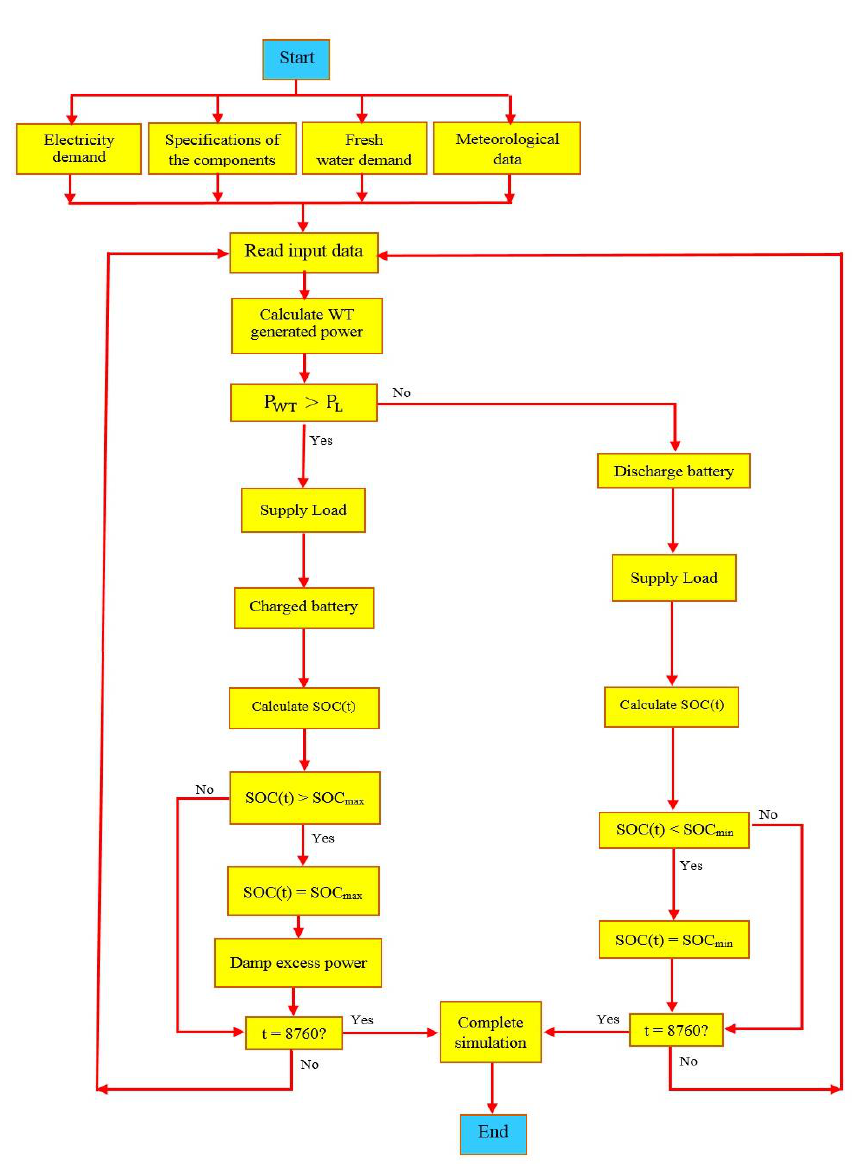
Figure 2. Flowchart of the power control and management for power system considered. Adapted